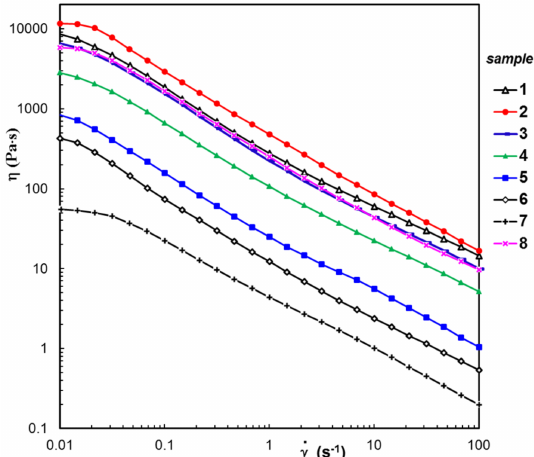
. γ ) for the hydrogel samples